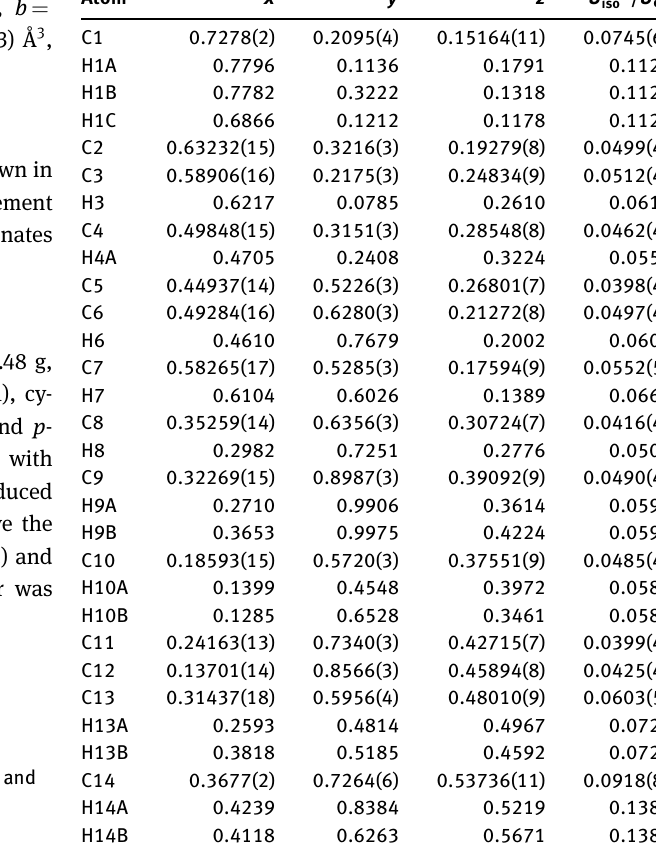
Table 2: Fractional atomic coordinates and isotropic or equivalent isotropic displacement parameters (Å 2